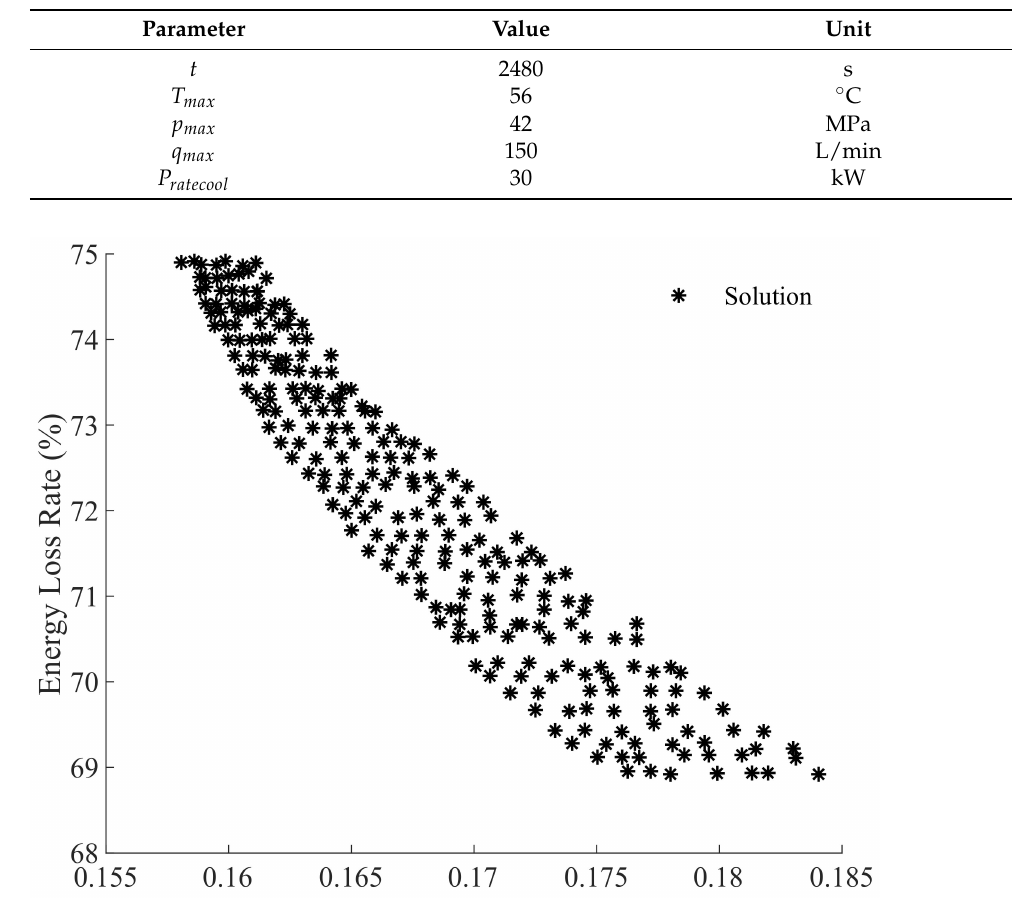
Table 2. Parameters of the DP algorithm.